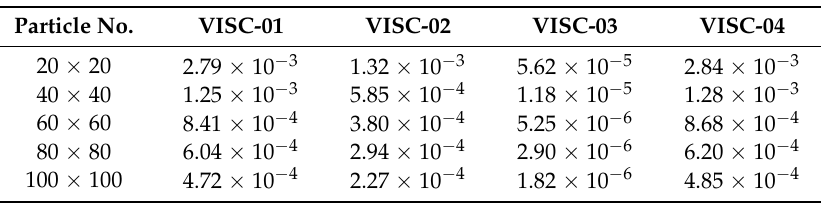
Table 2. Mean errors with different particle numbers and viscosity calculation methods under the non-uniform particle distribution.